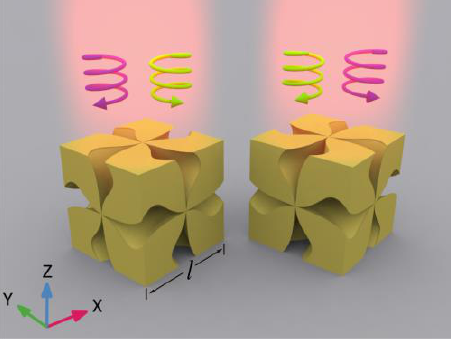
Figure 1. Two chirality types of particle structure (L-handed and R-handed) illuminated with circularly polarized light; l is the side length of GHNP.